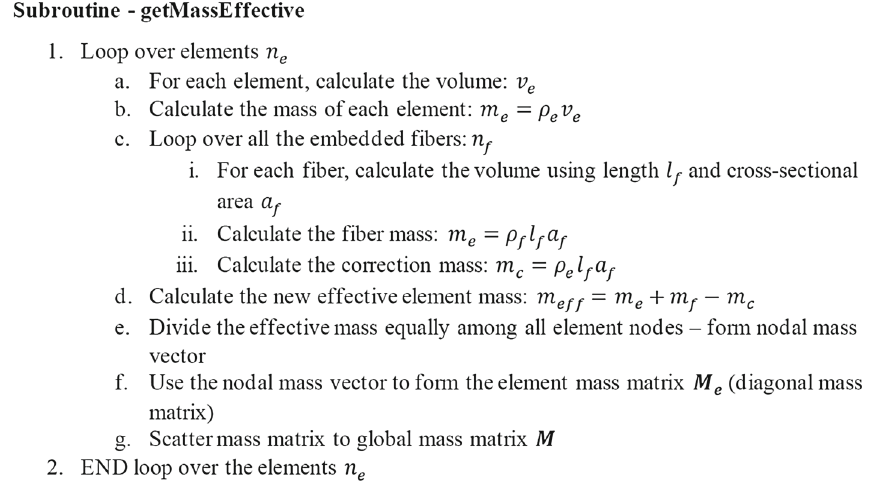
Fig. 9 Algorithm suggested by Garimella [20] to address mass redundancy